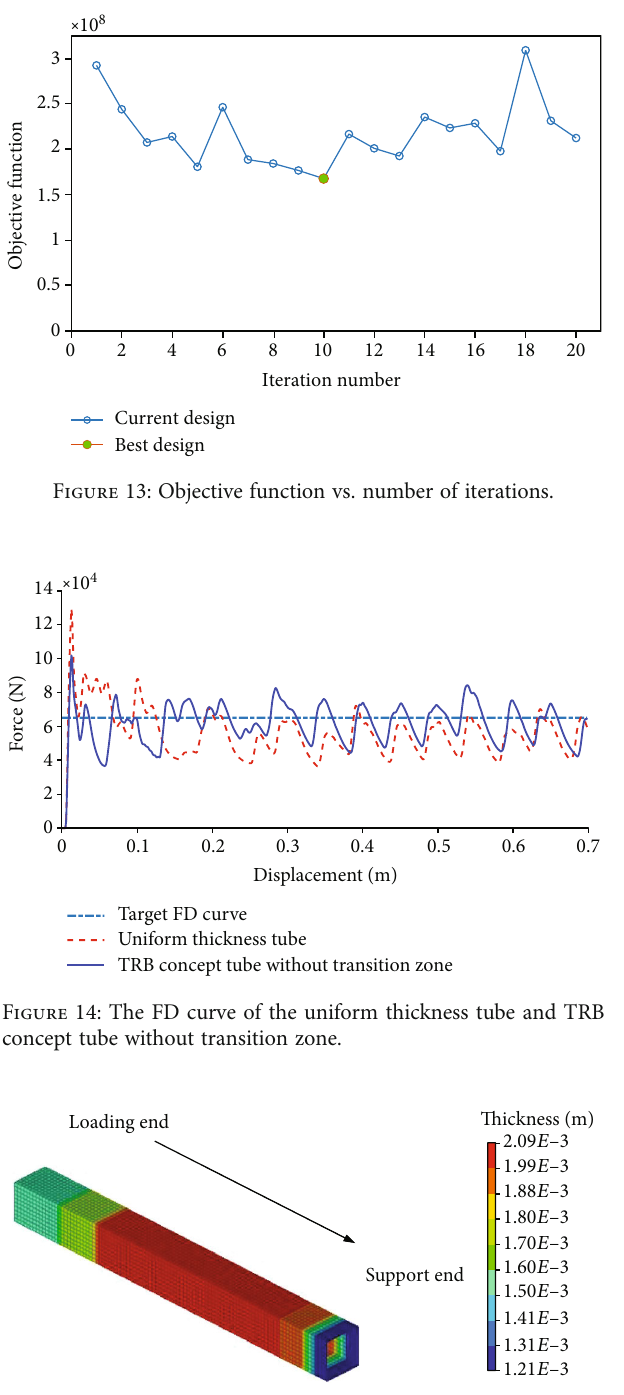
Figure 15: Thickness distribution of the TRB concept tube without transition zone.